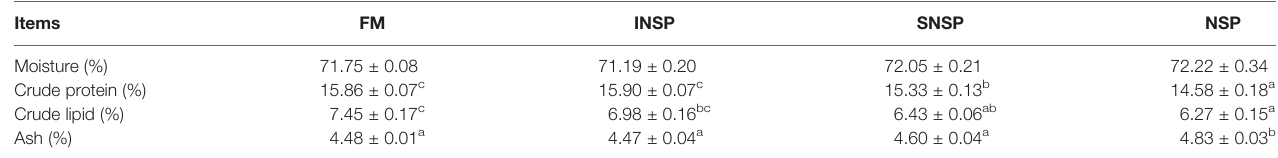
Values are means ± SEM (n = 3). Means in the same row with different superscripts are signi fi cantly different from each other (P <